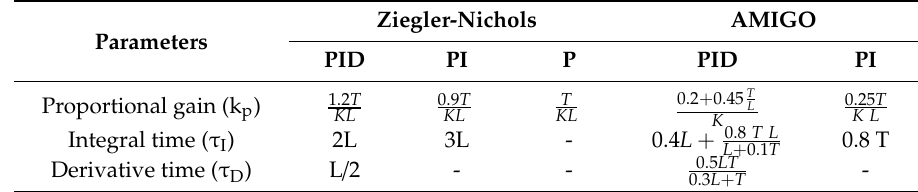
Table 1. Tuning rule for the step response method.